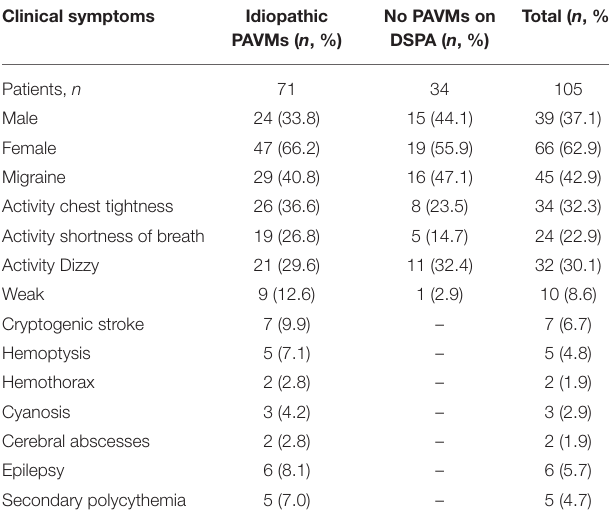
TABLE 1 | The basic information and clinical symptoms of included